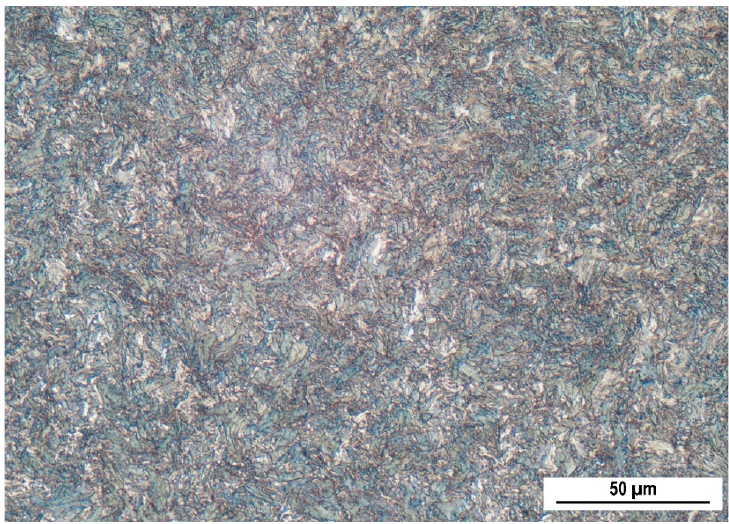
Figure 1. Sorbitic–pearlite microstructure—cross-sectional view.